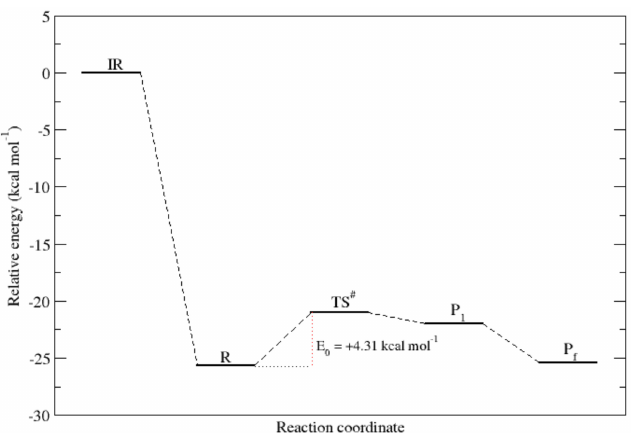
Figure 2. Reaction energies of the Gly-TS5 path with respect to isolated reactants as computed using ZPE corrected electronic energies.